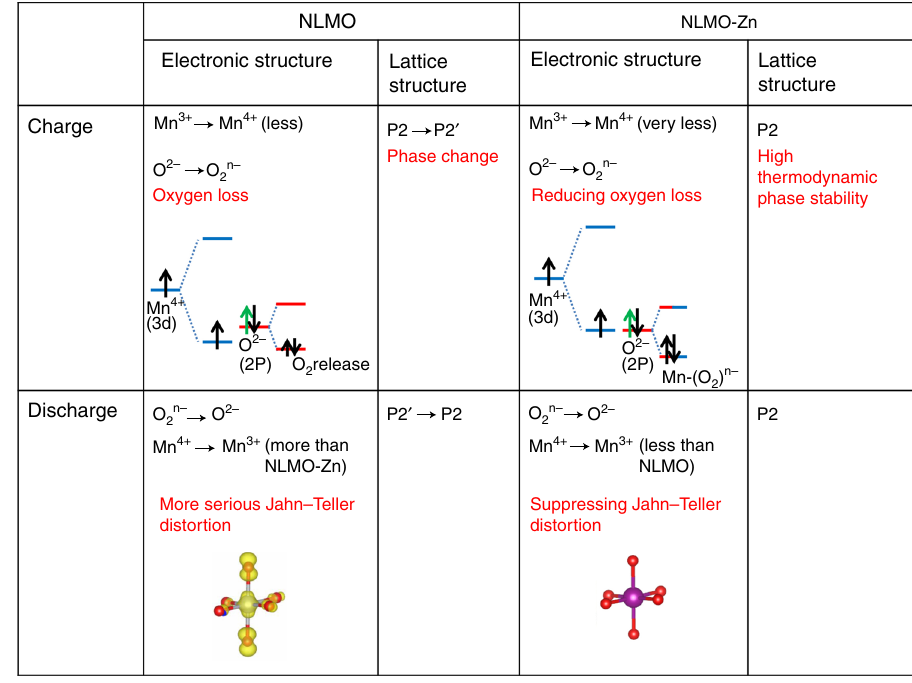
Fig. 8 The comparative electronic and lattice structure changes between NLMO and